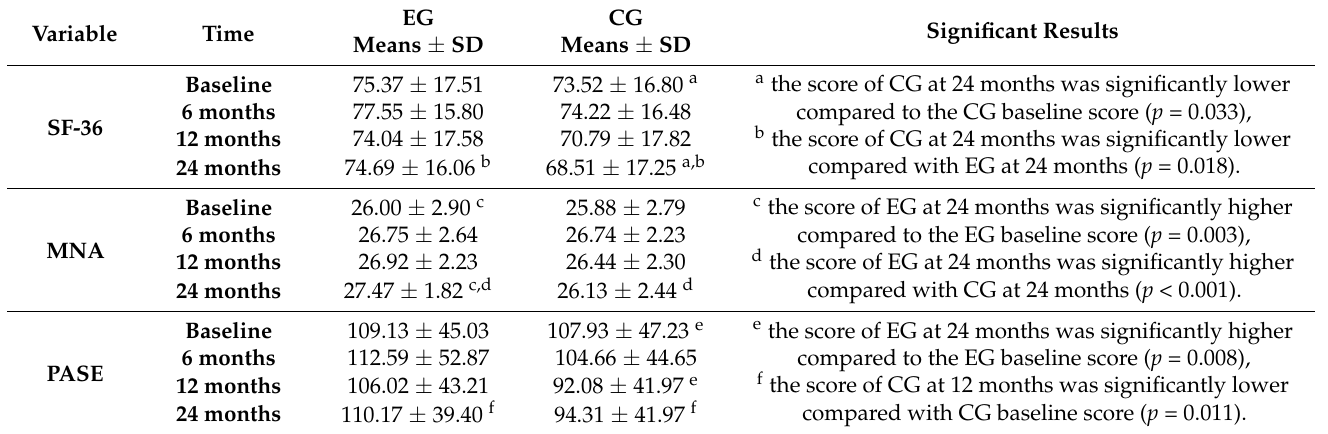
Table 2. Results obtained by the two groups in the three